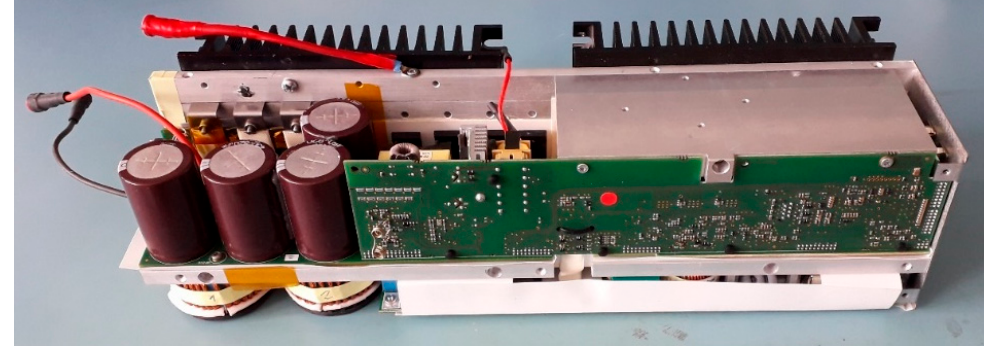
Figure 5. Physical prototype of three-phase PFC converter used for optimization purposes and evaluation. Table 7. Types of GaN and SiC transistors which have undergone experimental testing.